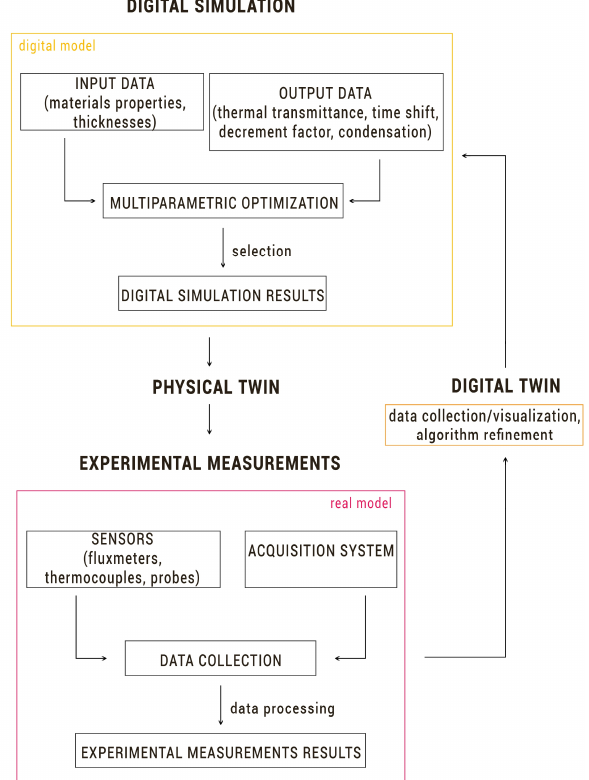
Figure 7. The process begins with a digital simulation that leads the development of the Physical Twin. The data obtained from the real model's sensors are sent to the Digital Twin, which allows the initial algorithm to be